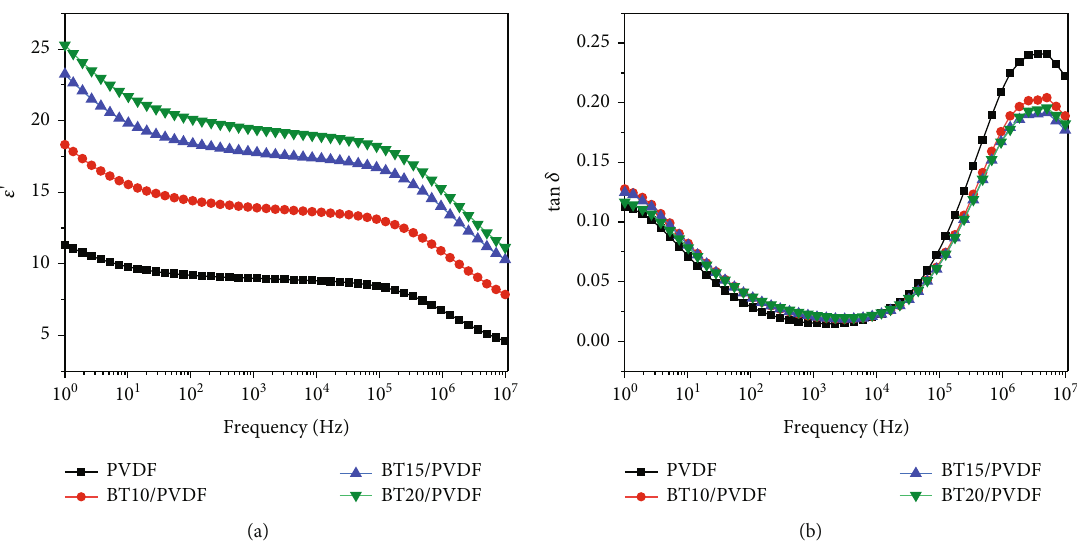
Figure 10: The real part of the complex permittivity (a) and the loss factor (b) of PVDF and BT/PVDF composites as a function of